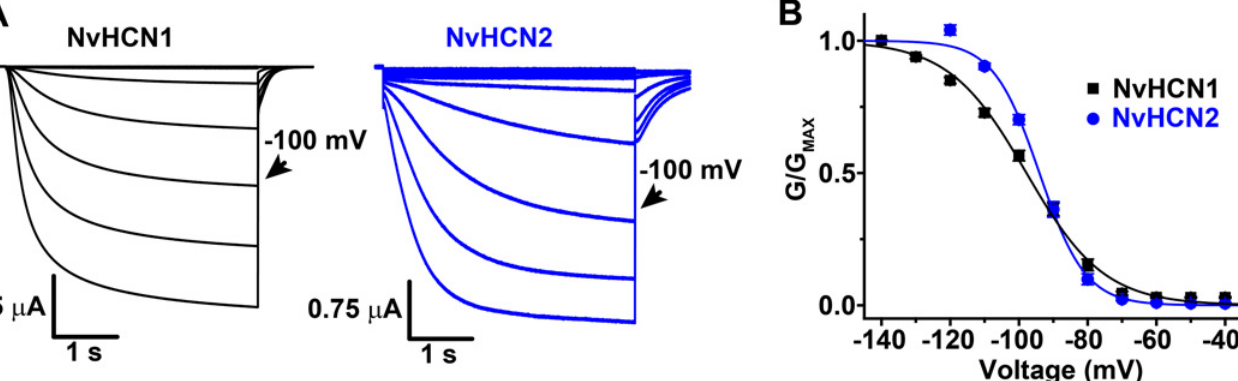
Fig 3. Nematostella HCN orthologs NvHCN1 and NvHCN2 are activated by hyperpolarization. (A) Families of inward currents recorded from Xenopus oocytes expressing NvHCN1 (left) and NvHCN2 (right) in response to 4 s hyperpolarizing voltage steps ranging from -40 to -120 mV in 10 mV increments. The holding potential was -30 mV and tail currents were recorded at -50 mV. Scale bars indicate time and current size and the -100 mV sweep is indicated with an arrow. (B) GV curves for NvHCN1 and NvHCN2. Fractional open probability (G/G MAX ) was measured from isochronal tail currents recorded at -50 mV after 4 s hyperpolarizing steps to the indicated voltages as shown in (A). Data are normalized and show mean ± S.E.M. of measurements from individual cells. The smooth curves show single Boltzmann fits. V 50 , slope values and sample numbers are reported in Table 1.